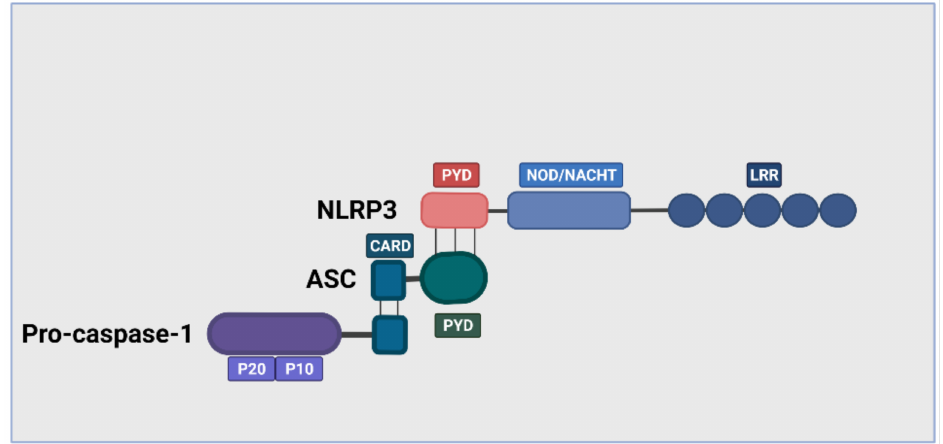
Figure 1. Structure of the complex NLRP3 inflammasome. The NLRP3 inflammasome contains an NLRP3 receptor, an ASC adaptor, and pro-cysteinyl aspartate specific proteinase-1 (pro-caspase-1). NLRP3 comprises of carboxyl (C) terminal (LRR), a central terminal, and an amino acid (N) terminal (PYD). The sensor C-terminal LRR recognizes PAMPs and DAMPs, the central terminal NACHT encodes by NLRP3 (CIAS1) gen, and the N-terminal CARD interacts with the adaptor protein through PYD-PYD. ASC recruits procaspase-1 through CARD domain to activate downstream